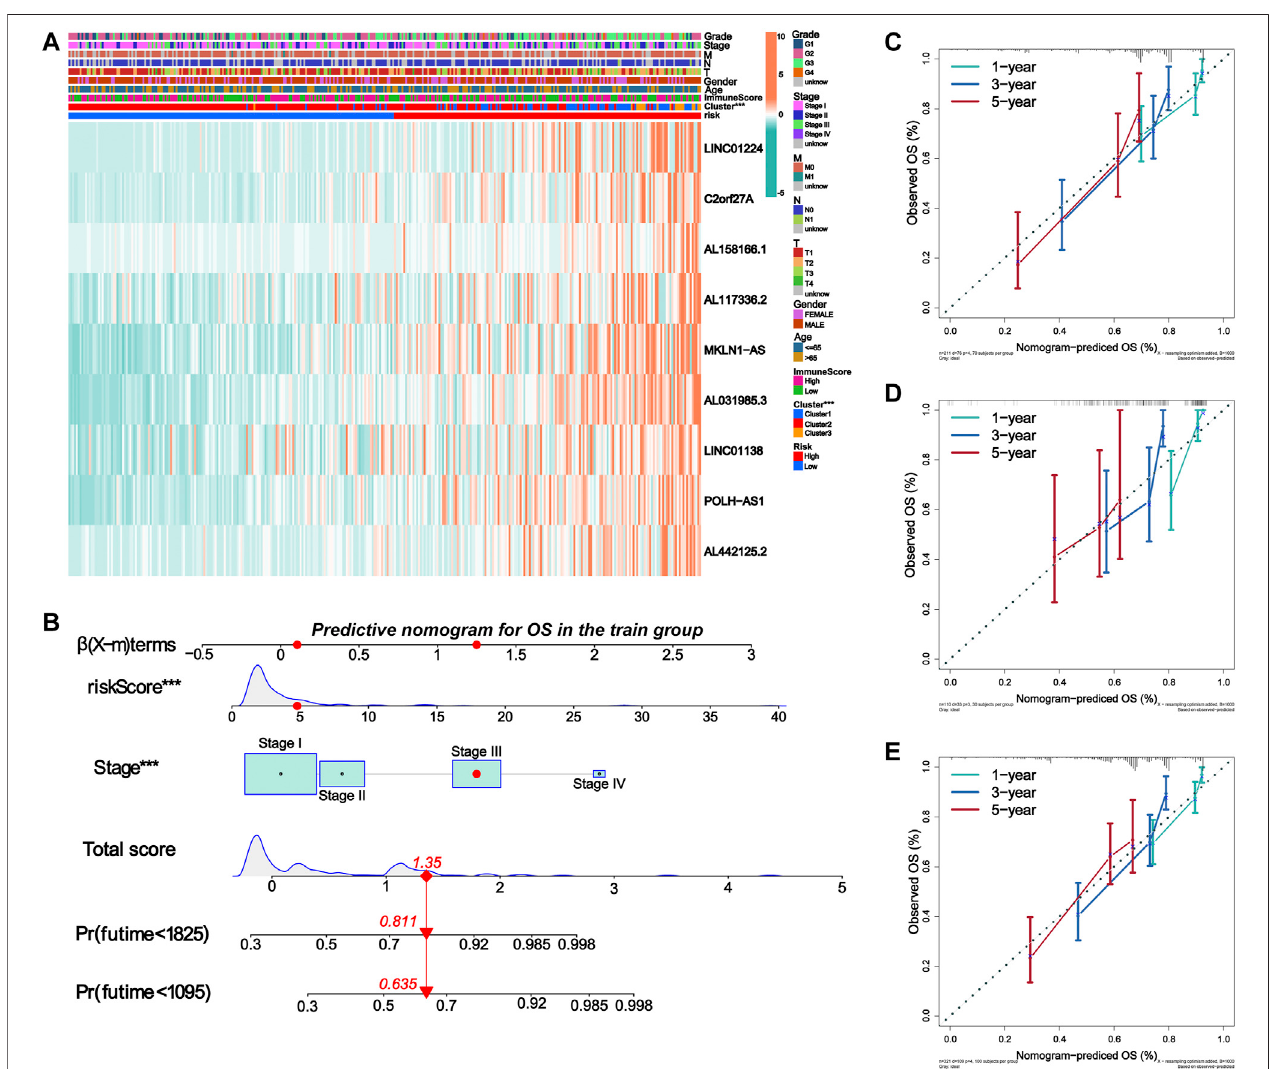
FIGURE 8 | Establishment of nomogram for predicting prognosis of HCC patients. (A) The expression of nine lncRNAs in m6A-9LPS was correlated with the clustering characteristics, stromal cell score, immune cell score, comprehensive score, and clinical factors. (B) Nomogram for predicting OS of HCC patients constructed based on training cohort patients and signi fi cant clinical factors of multivariate Cox regression analysis. (C – E) The calibration curves of the Nomogram predicted 1-year, 3-year, and 5-year OS in the training, validation, and entire cohort.